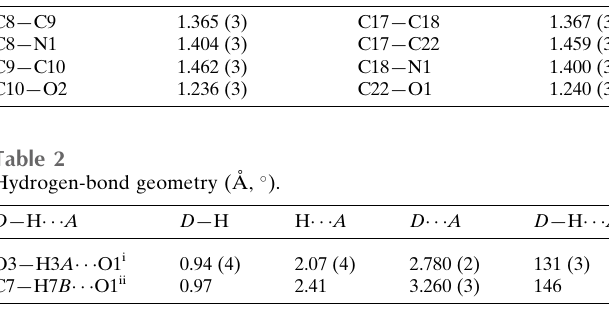
Table 1 Selected bond lengths (A˚ ).